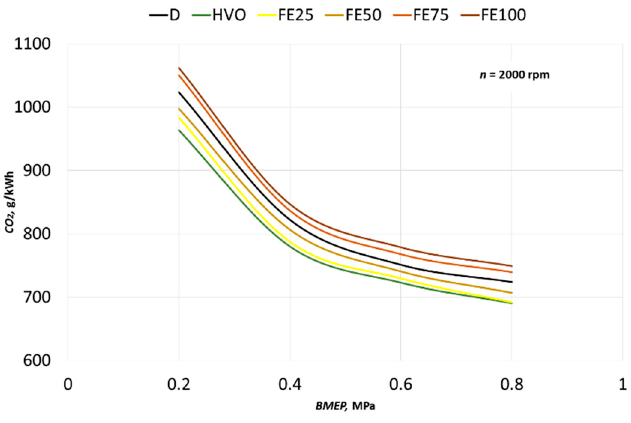
Figure 9. Dependence of carbon dioxide emissions on the